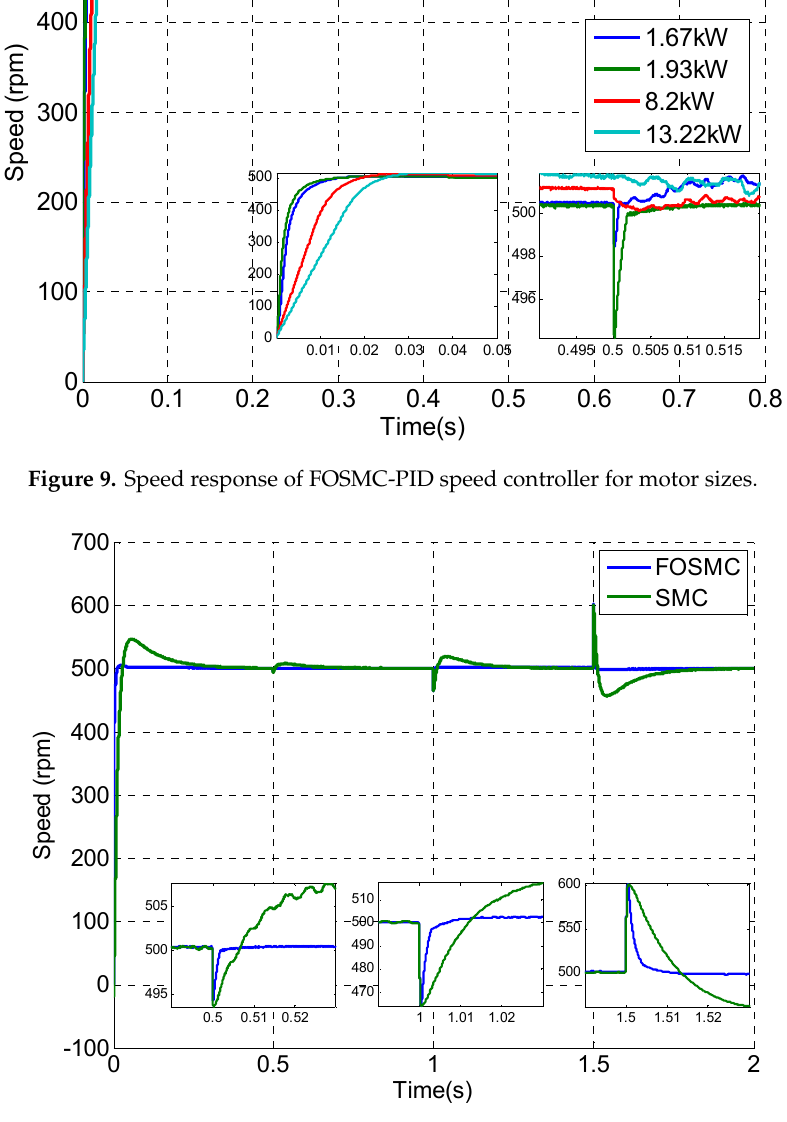
Figure 10. Comparison of speed response of FOSMC and SMC speed controller when positive and negative loads are applied.